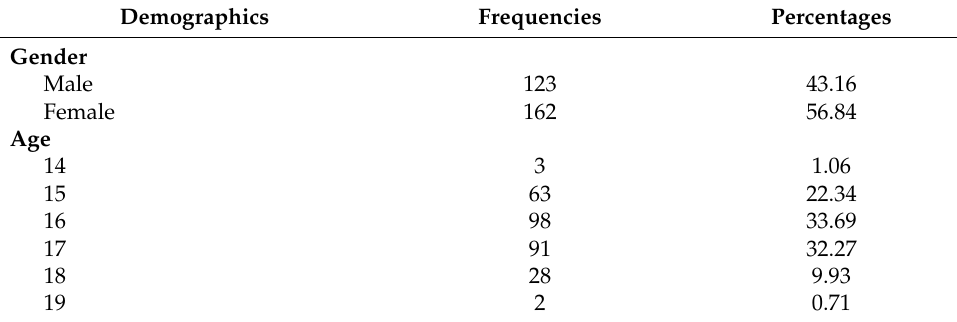
Table 2. Demographic